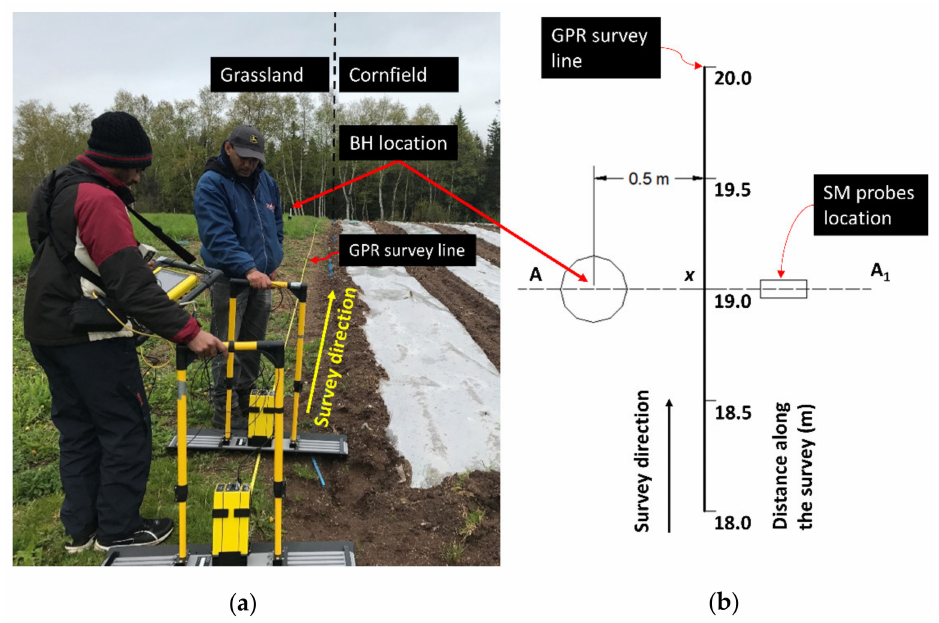
Figure 2. ( a ) Photograph captured during a 100 MHz survey at the starting point of the ground penetrating radar (GPR) survey line. ( b ) Plan view of the borehole (BH) location with GPR survey line and the location of soil moisture (SM) probes. A–A 1 cross section is illustrated in Figure 3. The intersection of the A–A 1 section and GPR survey line is marked as “ x ”.